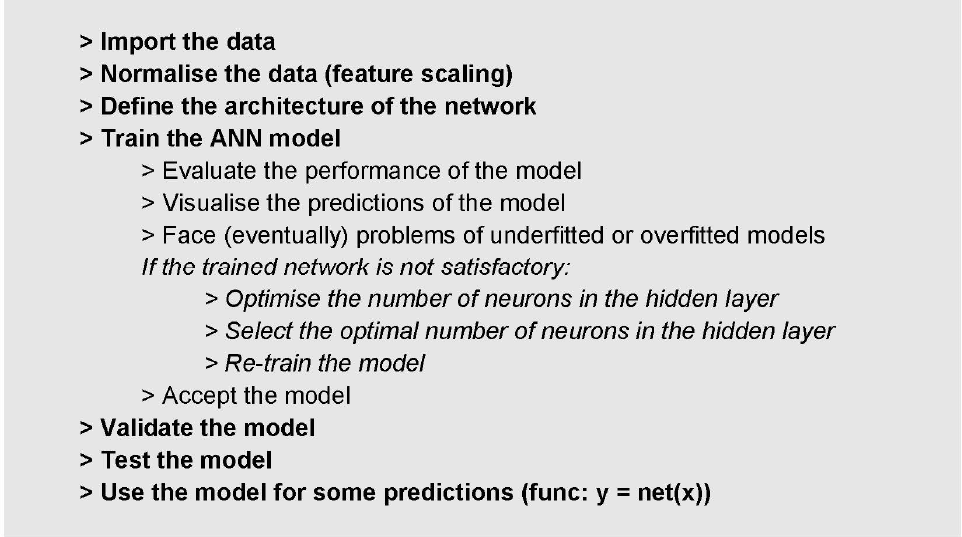
Figure 11. ANN pseudocode. Figure 11. ANN